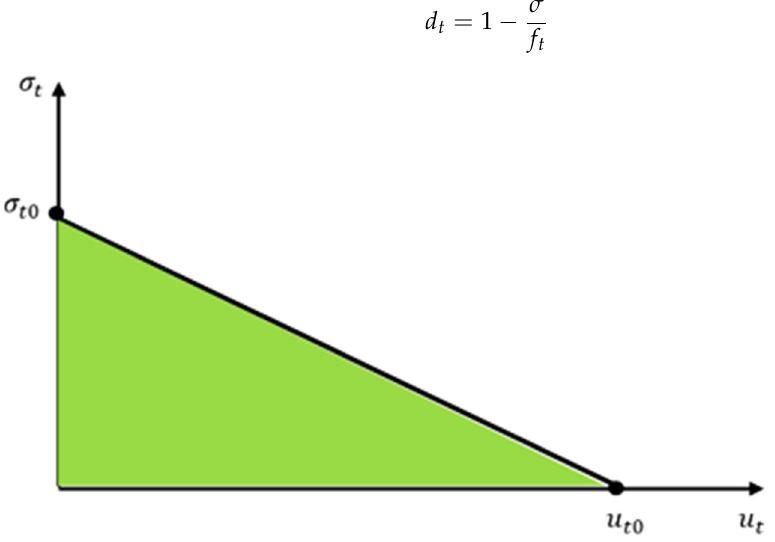
Figure 3. Definition of the tensile behavior of concrete after cracking.